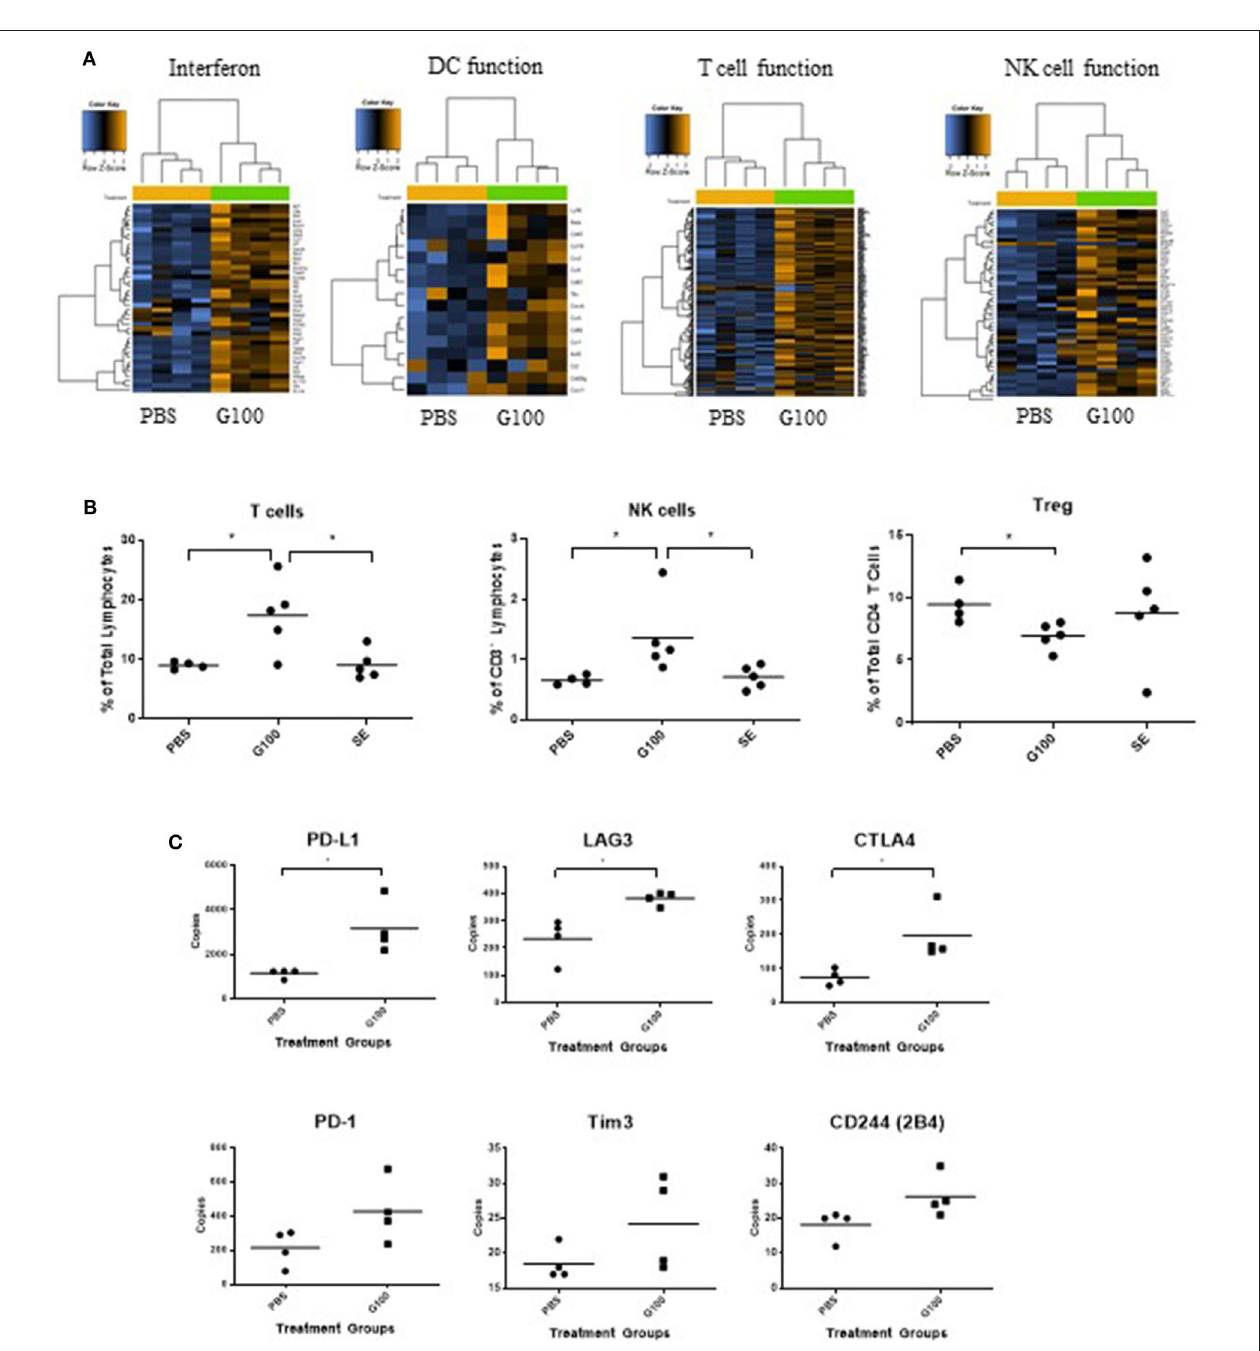
FIGURE 3 | G100 inflames TME of A20 tumors. (A) A20 tumors ( n = 4 mice/group) treated with G100 (10 µ g/ml GLA, 2%SE) for 1 week (3 injections, every other day) were collected for gene expression analysis by Nanostring. Multiple immune response pathways, including type 1 interferon signaling, DC function, T cell, and NK cell functions, were all activated. (B) Tumor infiltrating lymphocytes (TIL) were collected for Flow cytometry analysis and stained with antibodies for CD3, CD4, CD8, Foxp3, and NKp46. G100 treatment induced significant increase in T cells and NK cells and a decrease in T reg among CD4T cells. SE treatment was no different from PBS control in any of the markers. (C) Gene expression levels of T cell exhaustion markers in G100-treated and non-treated tumors ( n = 4 mice/group). * p < 0.05 by student t -test.